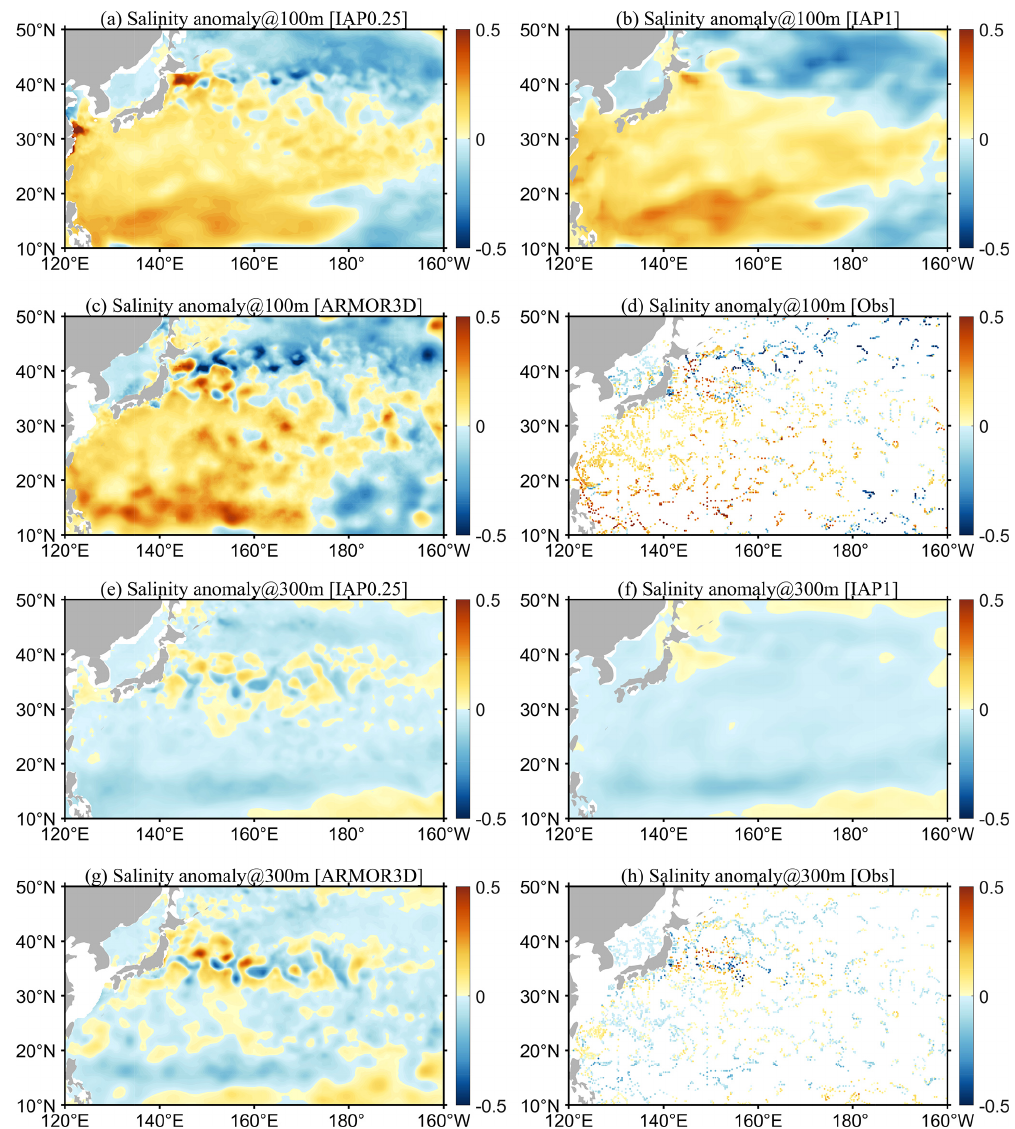
Figure 6. The geographical distribution of salinity anomalies in the Kuroshio and its extension region for IAP0.25 ◦ , IAP1 ◦ , ARMOR3D, and in situ observations in January 2016: (a–d) 100m and (e–f)